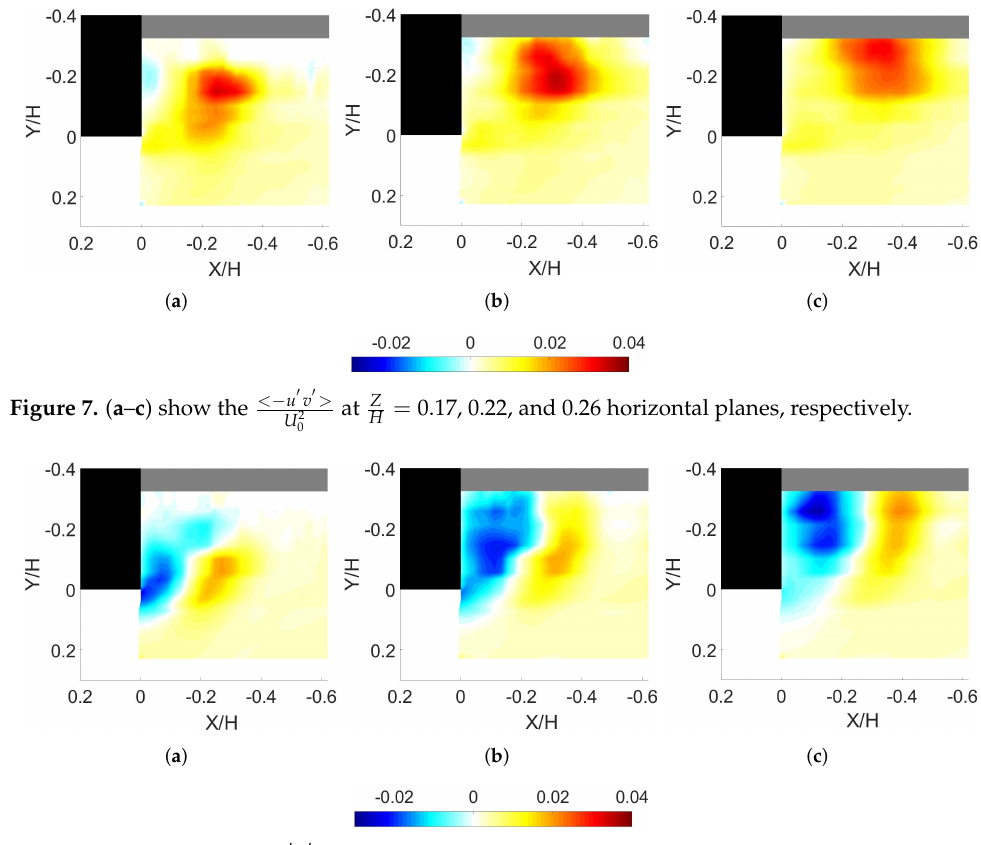
(cid:48) w (cid:48) > = 0.17, 0.22, and 0.26 horizontal planes, component at Z H U 2 0